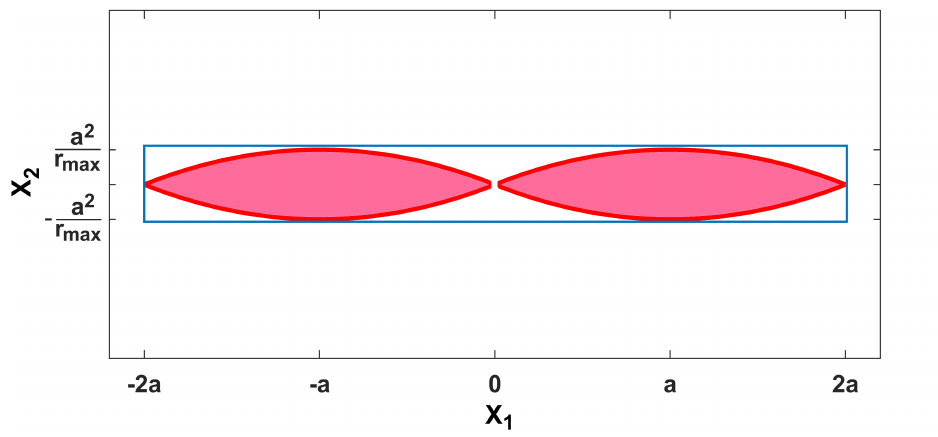
Figure 2. Shape of the integration domain Σ 1 and of the smallest rectangular that encloses